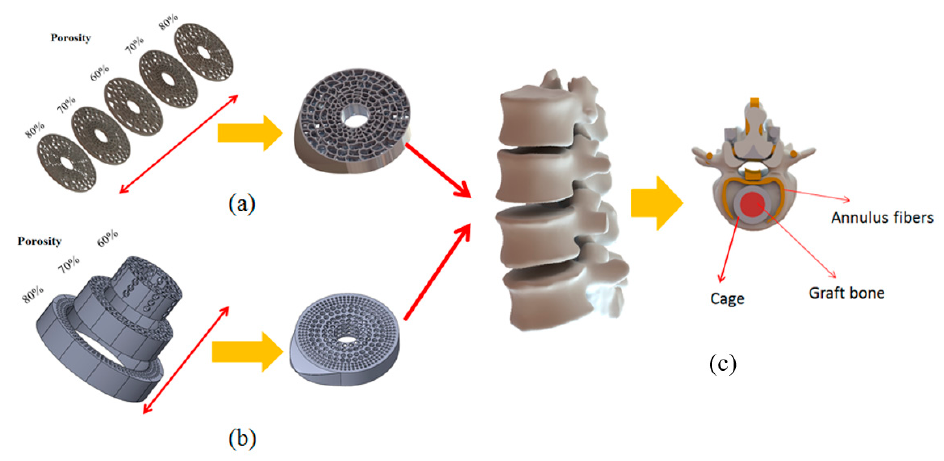
Figure 2. Gradient porosity structure for cages. ( a ) Vertically gradient porosity. ( b ) Horizontally gradient porosity. ( c ) Cage placement in spinal fusion surgery.